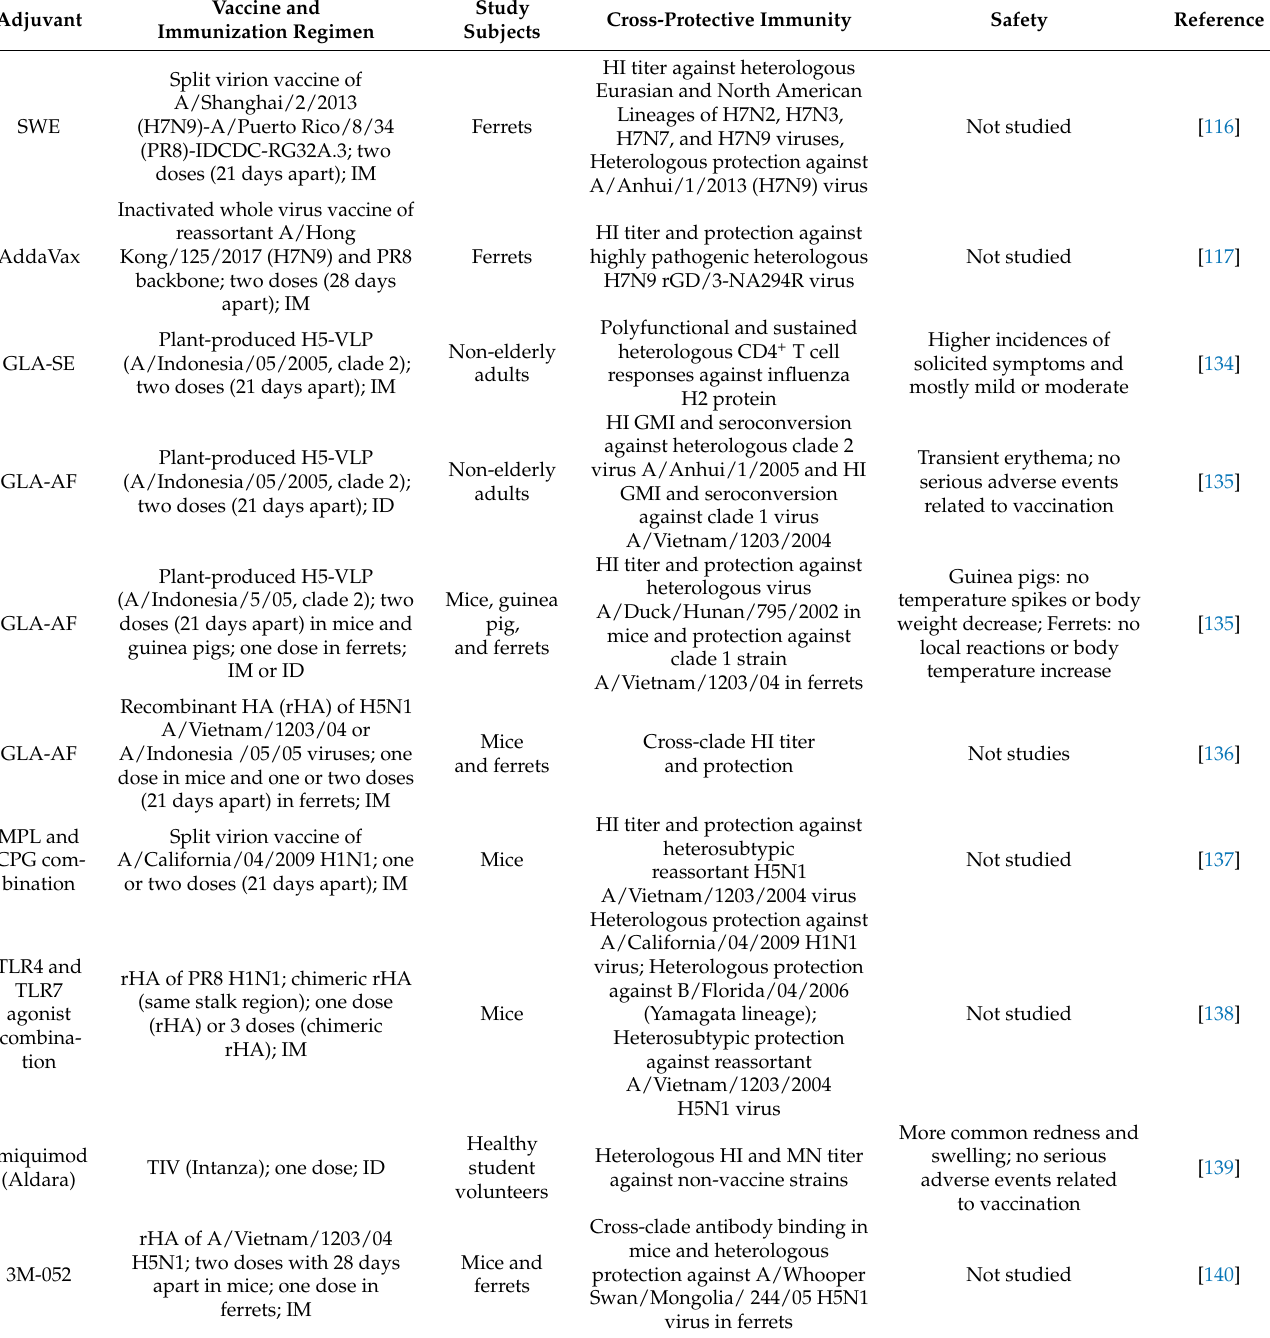
Table 4. Experimental adjuvants assist influenza vaccines to induce cross-protective